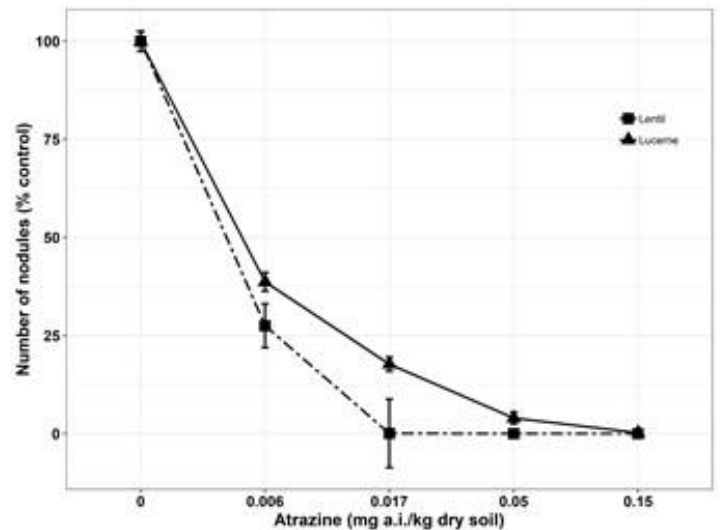
Figure 5. Effect of different levels of atrazine concentrations on number of nodules of lucerne and lentil at 28 days after sowing (DAS). Lines denote predicted responses according to the equations reported in the materials and methods section. Symbols shown on the graphs are the original means of each parameter (% control) against each dose of trifluralin concentration. Mean value was pooled from four observational units for lentil and lucerne.